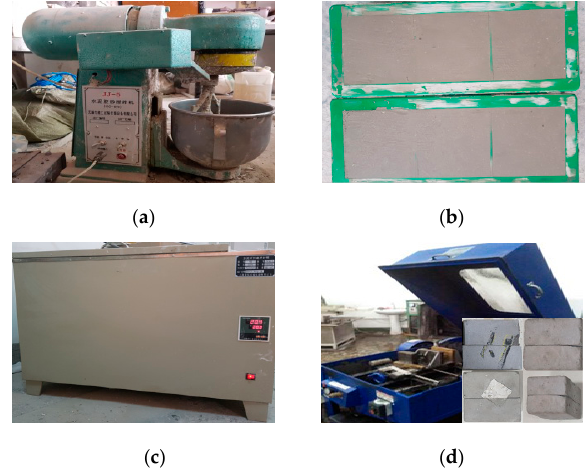
Figure 1. The preparation process of samples. ( a ) Cement mortar was stirred in a mixer. ( b ) Cement mortar was poured into molds. ( c ) Samples in a standard cement curing box. ( d ) Samples were cut.